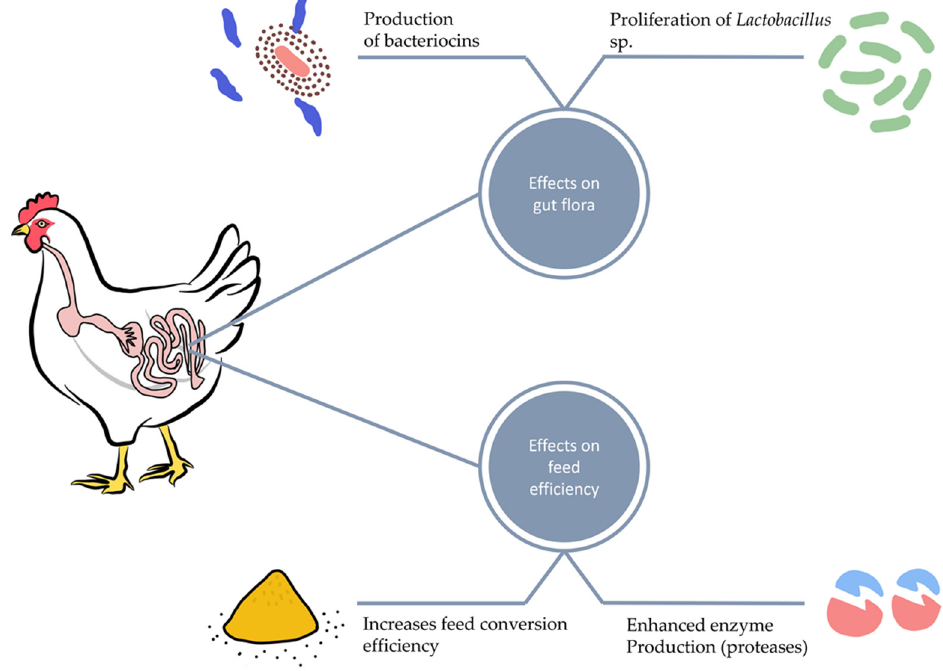
Figure 1. Effect of probiotics on growth performance, gut macroflora and feed efficiency.